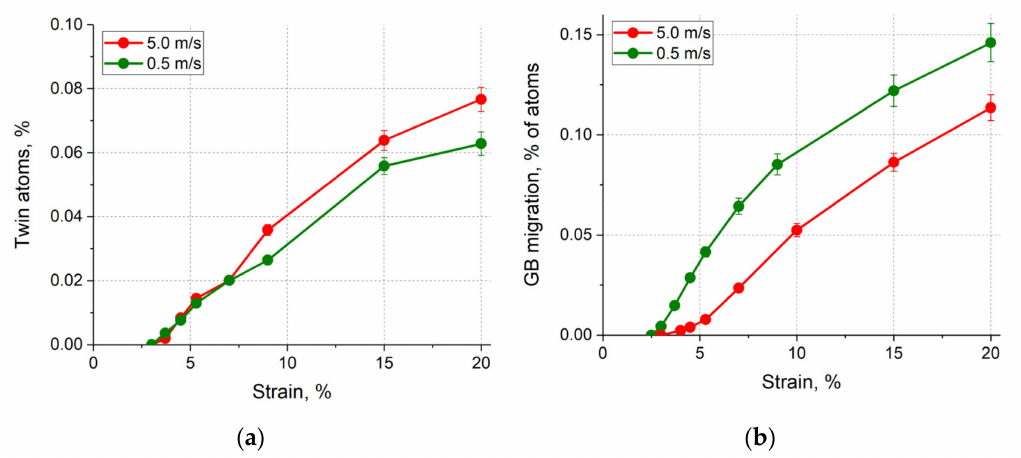
Figure 10. Strain dependence of the number of atoms forming twins ( a ) and the number of atoms through which GBs migrated ( b ) for two strain rates.